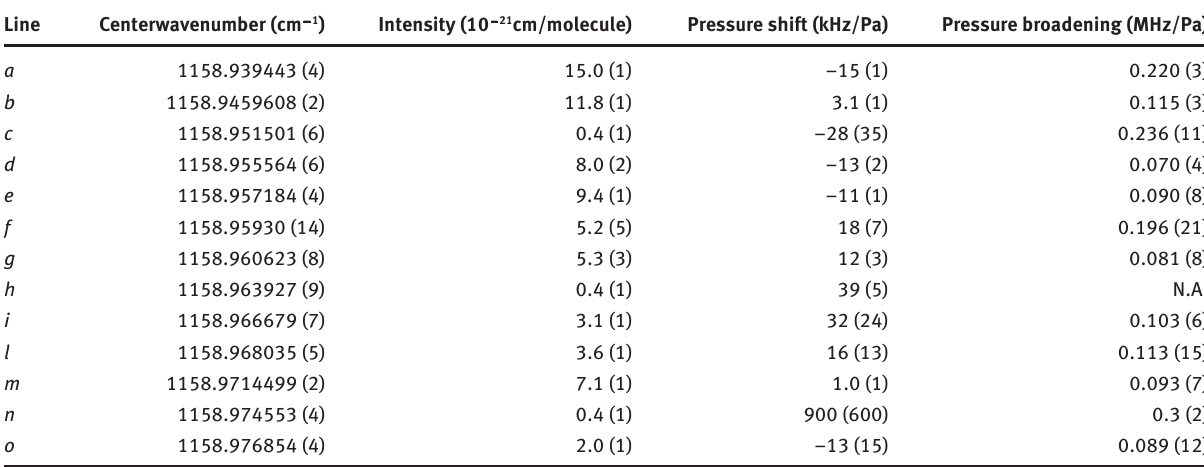
lines at 8.6 μ m. 3